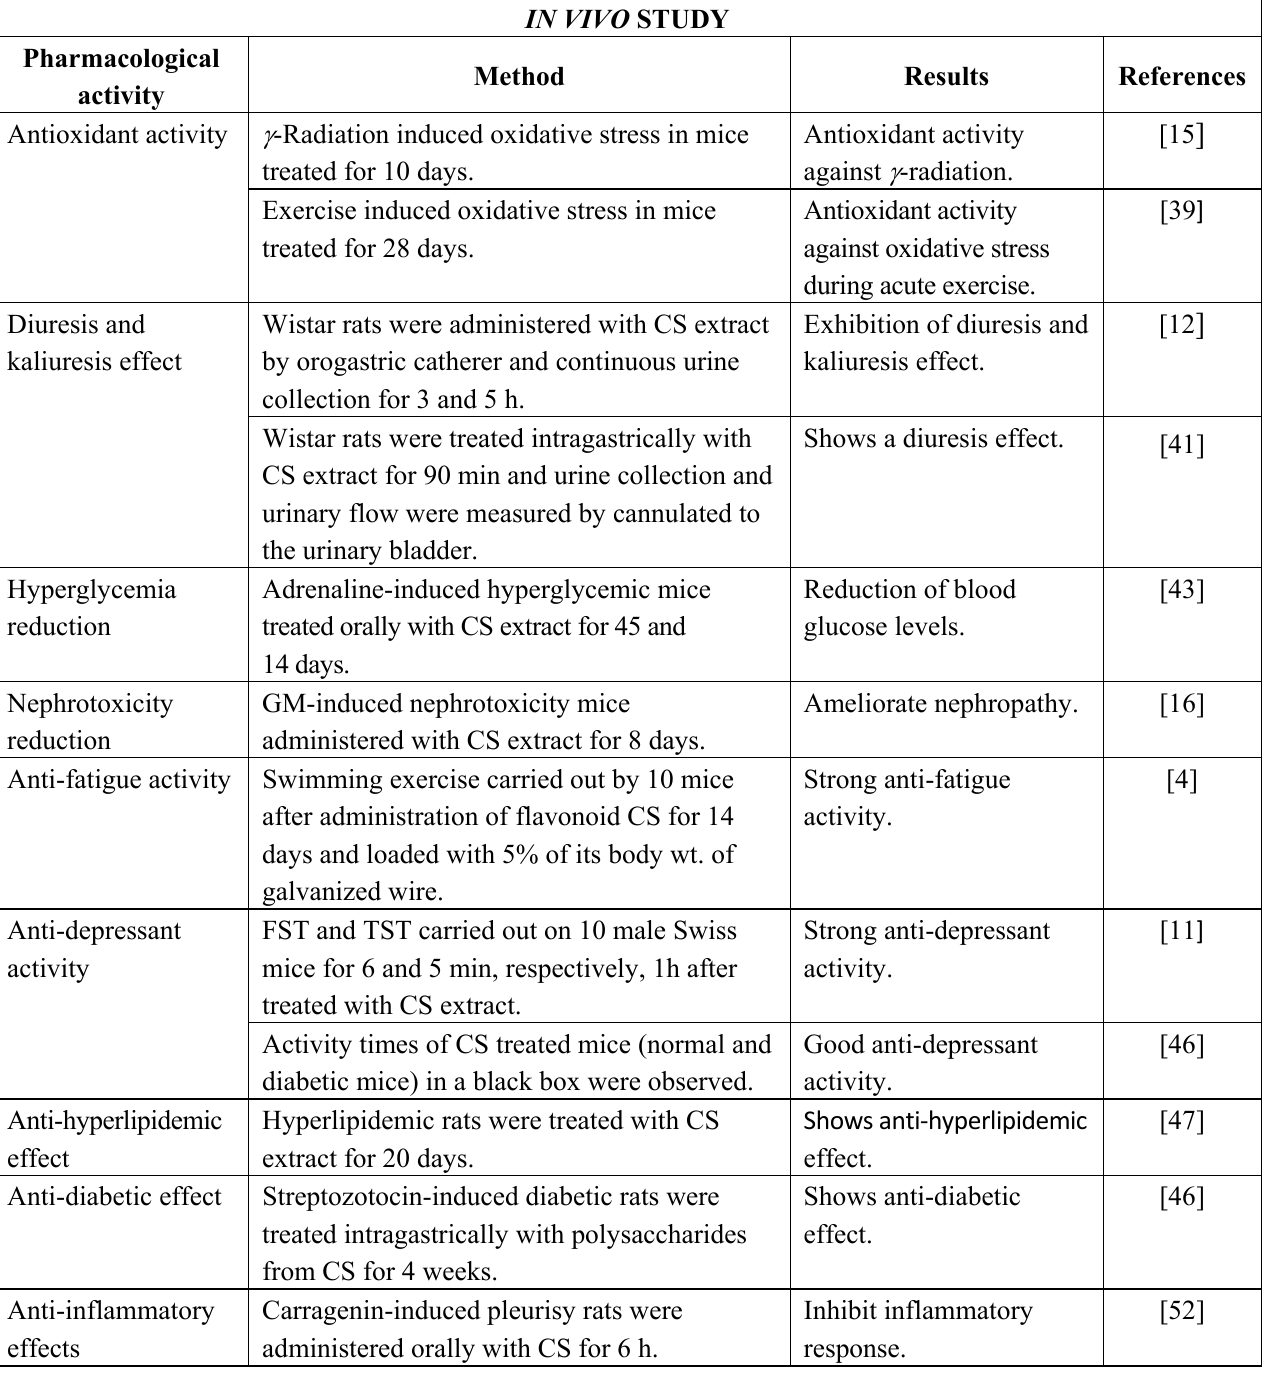
Table 1. Pharmacological activities in vitro and in vivo of corn silk